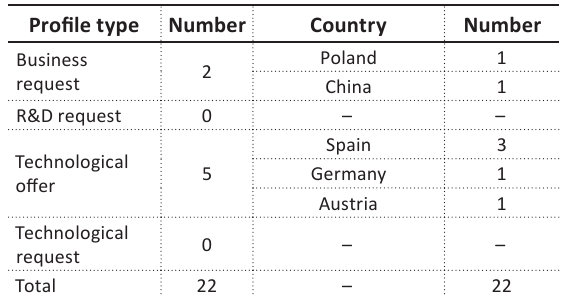
Table 6. Number of profiles of entrepreneurs in the market sector “Computer technologies” in the EEN system that are interested in cooperation with Ukraine for the first half of 2019